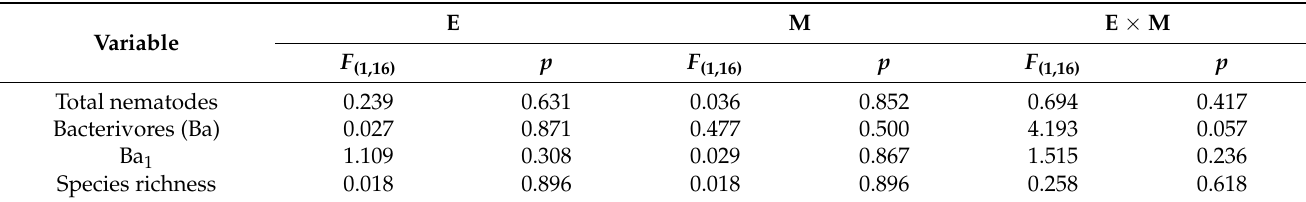
Table 2. Effects of earthworm addition (E) and millipede addition (M) on nematodes in leaf litter. Variable